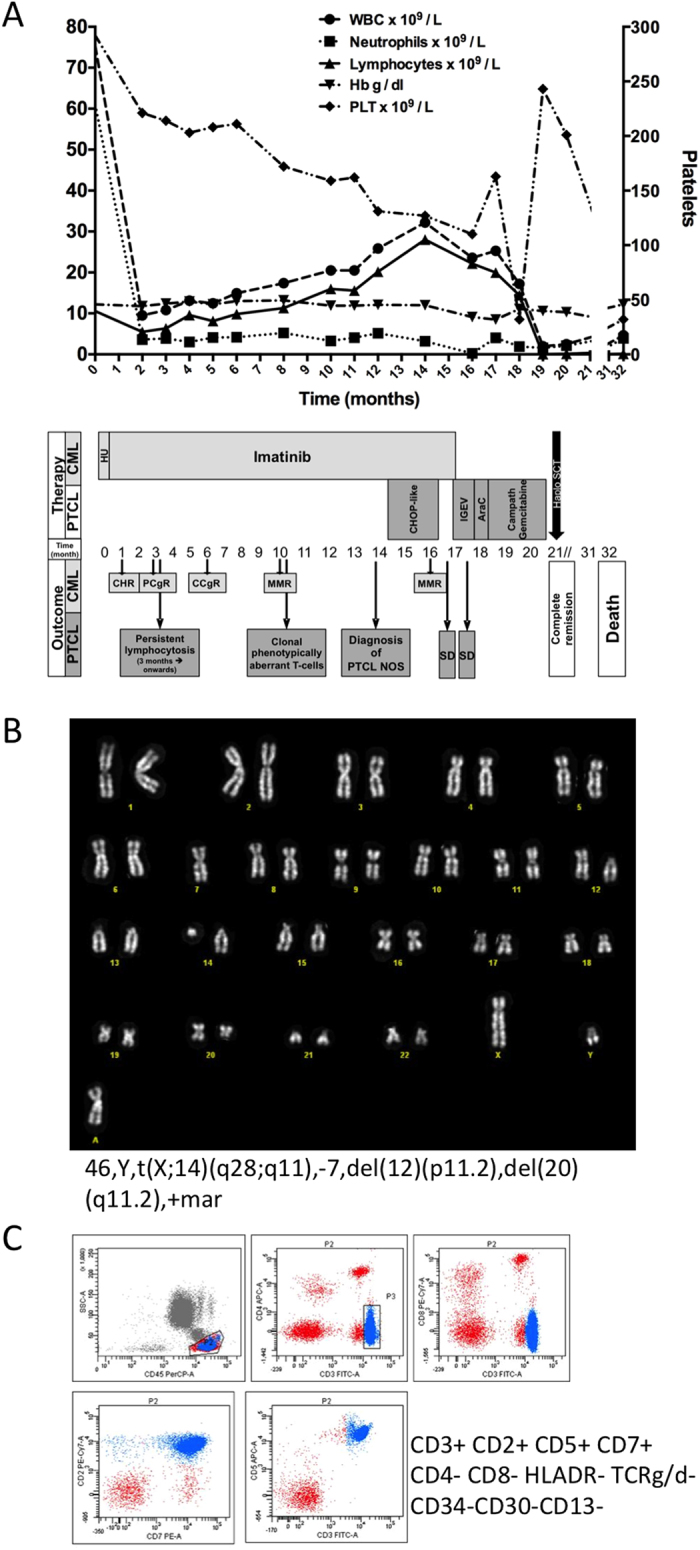
(A) Clinical and treatment history of the patient. Hb – haemoglobin, PLT – platelets, WBC – white blood count, HU – hydroxyurea, CHOP - cyclophosmamide, hydroxydaunorubicin, oncovin (vincristine), prednisone, IGEV - ifosfamide, gemcitabine, vinorelbine, CHR (complete haematological response), PCgR – partial cytogenetic response, CCgR – complete cytogenetic response, MMR – major molecular response, SD – stable disease, PTCL NOS – peripheral T-cell lymphoma not otherwise specified. (B) A representative karyotype obtained by culturing peripheral blood T-cells and staining the resulting metaphases with the standard Q-banding technique. (C) Immunophenotype of the peripheral blood T-cells showing the presence of an aberrant clone.